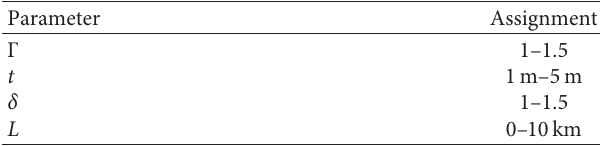
Table 5: Related parameter assignment.